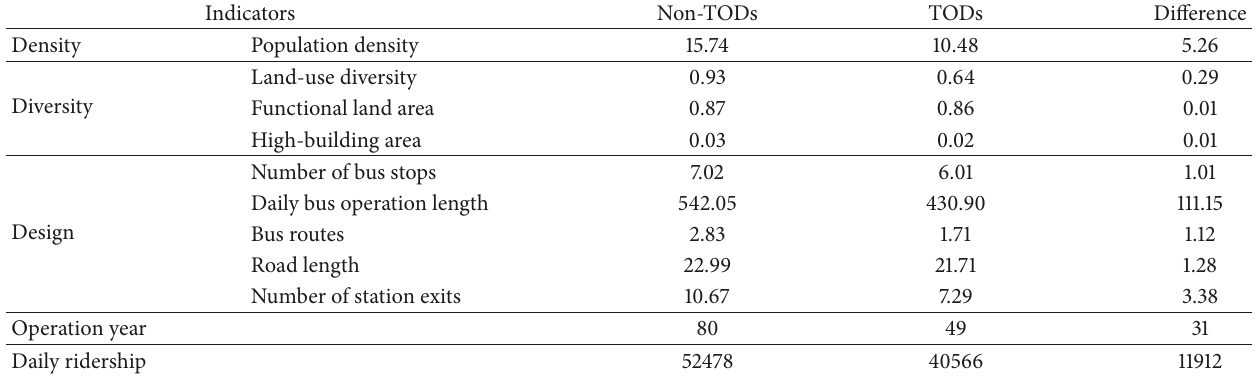
Table 4: Means of indicators of nontransfer